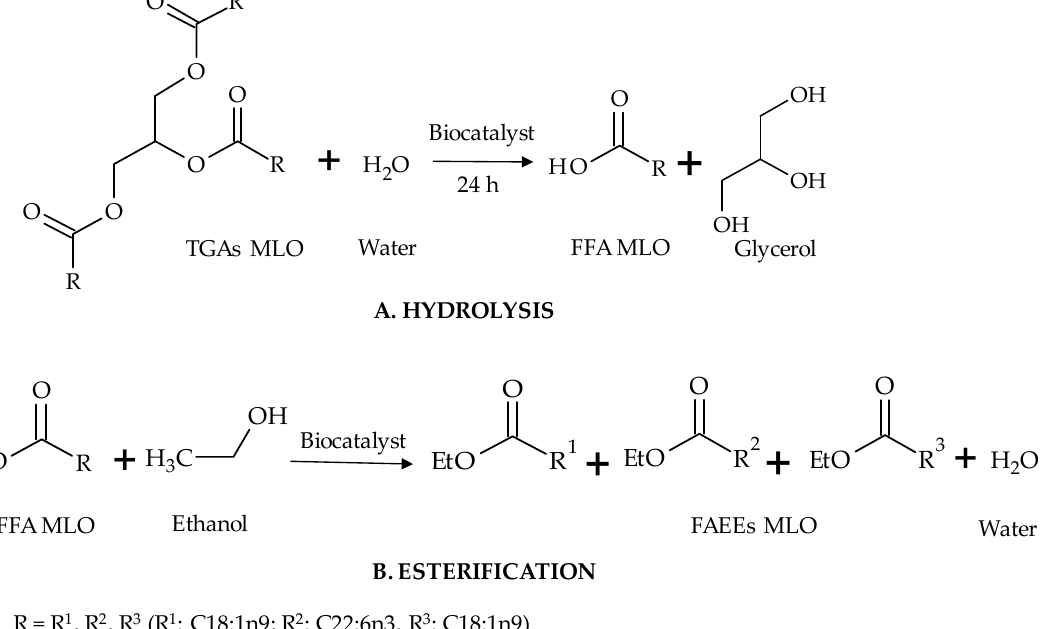
Figure 3. Schematic reaction diagram of the synthesis of ethyl esters in the two-step reaction ( A . hydrolysis followed by B . esterification reaction).